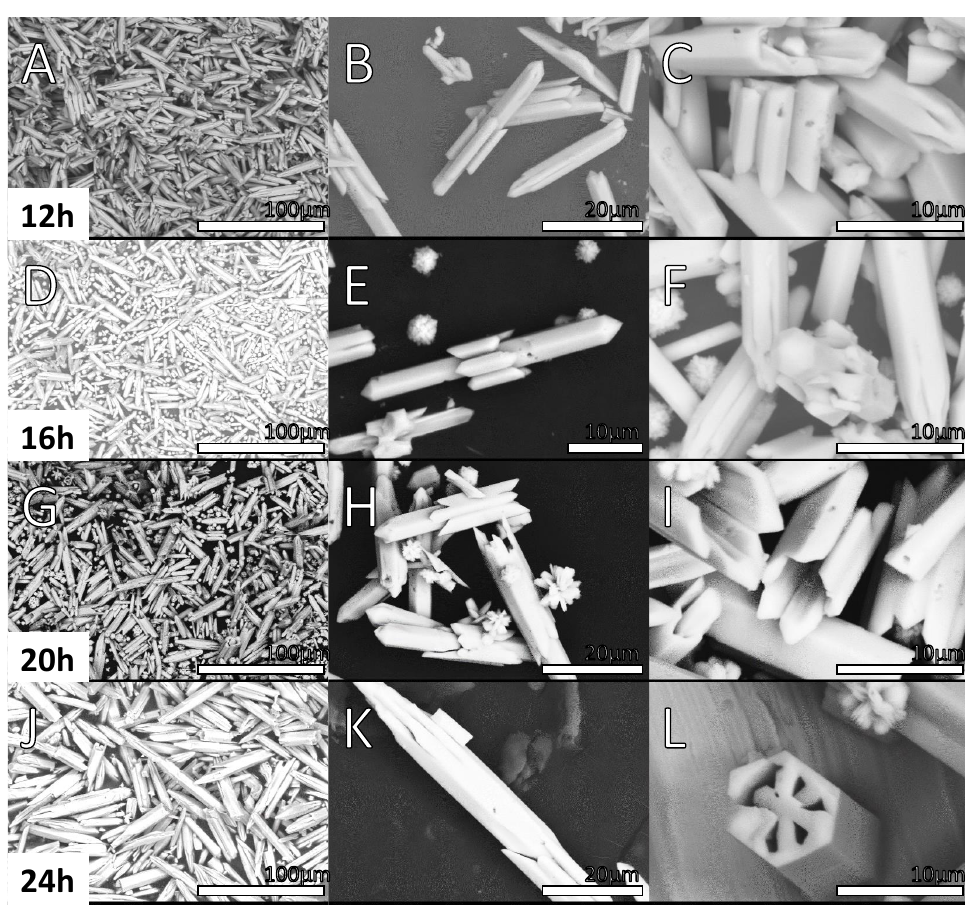
Figure 7 SEM micrographs of Y(OH) 3 Samples obtained at 12, 16, 20 and 24 h. Full-size DOI: 10.7717/peerjmatsci.23/fig-7